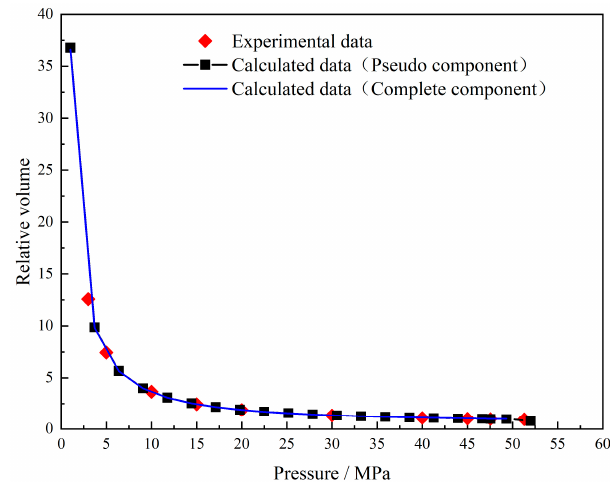
Figure 5. Relative volume fitting diagram.